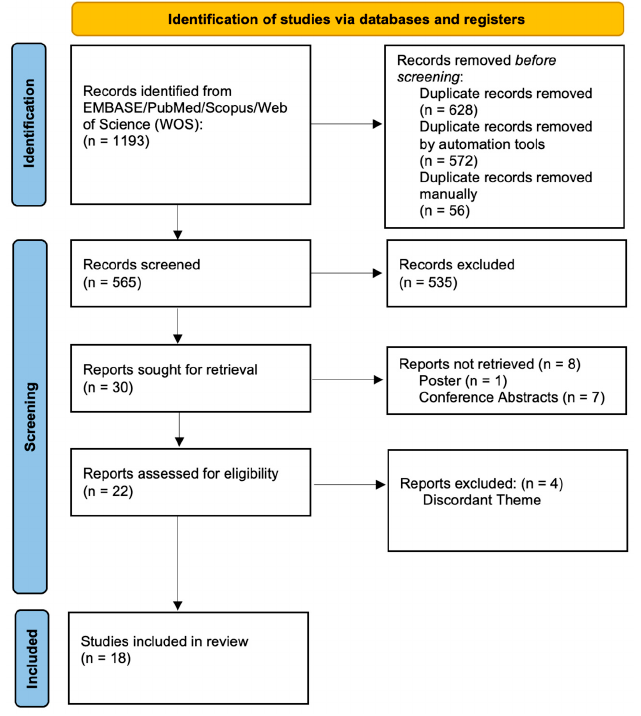
Figure 2. PRISMA flowchart